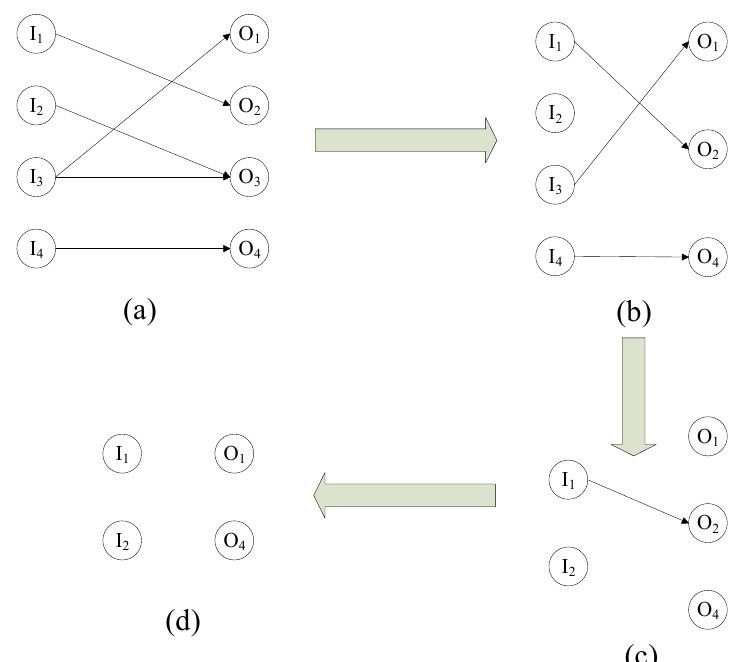
Figure 5. The newly-formed graph after each iteration of the newly-developed defect-tolerant algorithm.